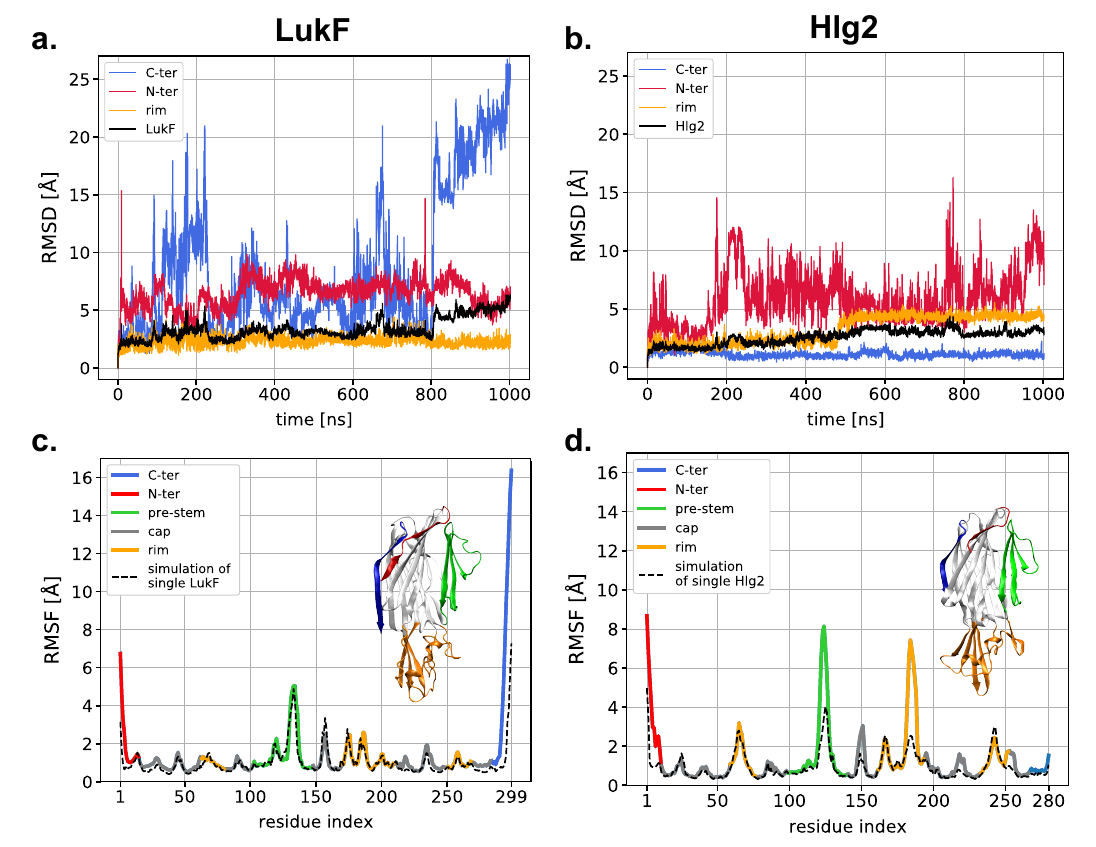
Figure 2. Time evolution of the RMSD for the ( a ) LukF and the ( b ) Hlg2 monomers in the replica where spontaneous dimerization on the membrane is observed. The colored lines correspond to the RMSD computed on different domains of the monomers, while the black line indicates the RMSD of the full proteins . For the same replica, the RMSF of the ( c ) LukF and the ( d ) Hlg2 residues (C α atoms) (solid lines colored according to the different monomer regions) is reported along with the RMSF of the monomers simulated alone (dashed black line). A graphical representation of the two monomers is also shown for